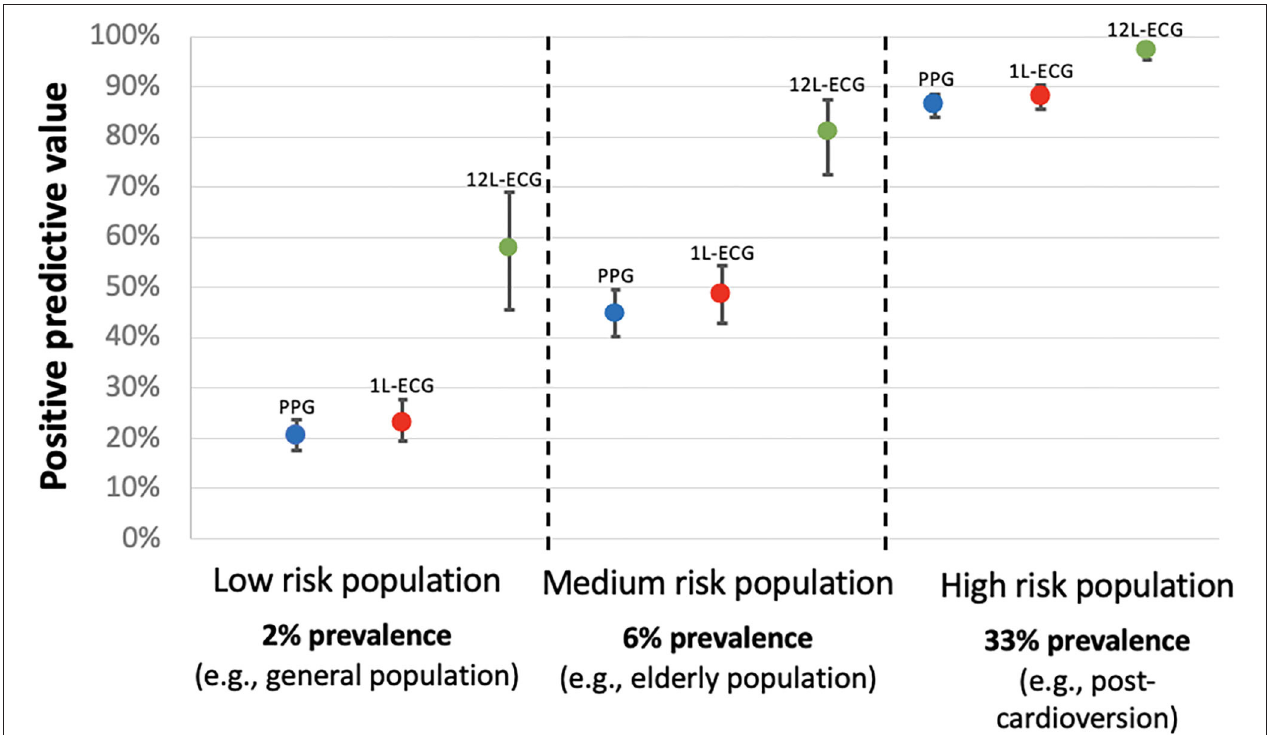
FIGURE 4 | Positive predictive value for AF detection according to the AF prevalence in the targeted population. 1L-ECG, single-lead electrocardiogram; 12L-ECG, 12-lead electrocardiogram; PPG, photoplethysmography (in this context refers to photoplethysmography waveform with tachogram and poincaré